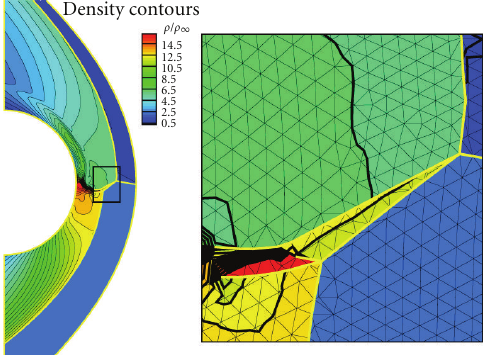
Figure 10: Type IV shock-shock interaction, M ∞ = 10: shock-fitting